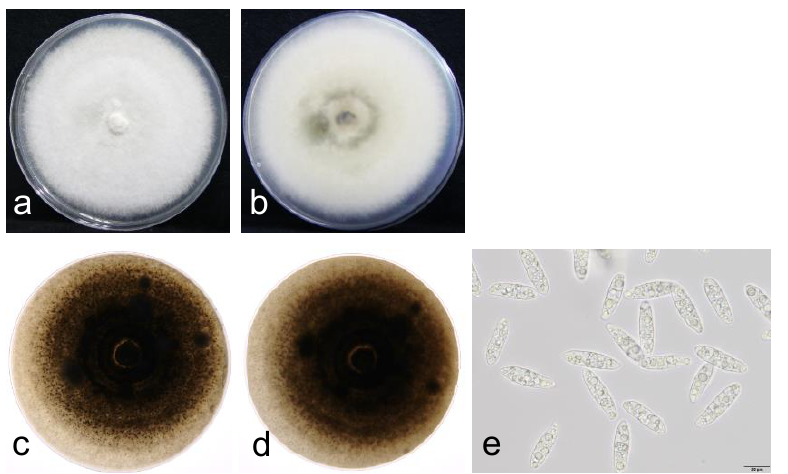
Figure 2. Symptoms of sugarcane leaf blight caused by isolate SF007. ( a ). Sugarcane plants infected for 15 days; ( b ). leaf infected for 3 days; ( c ). for 7 days; ( d ). for 10 days; ( e ). for 15 days; ( f ). for 30 days. Plants were kept in a glasshouse at 25 – 28 °C.